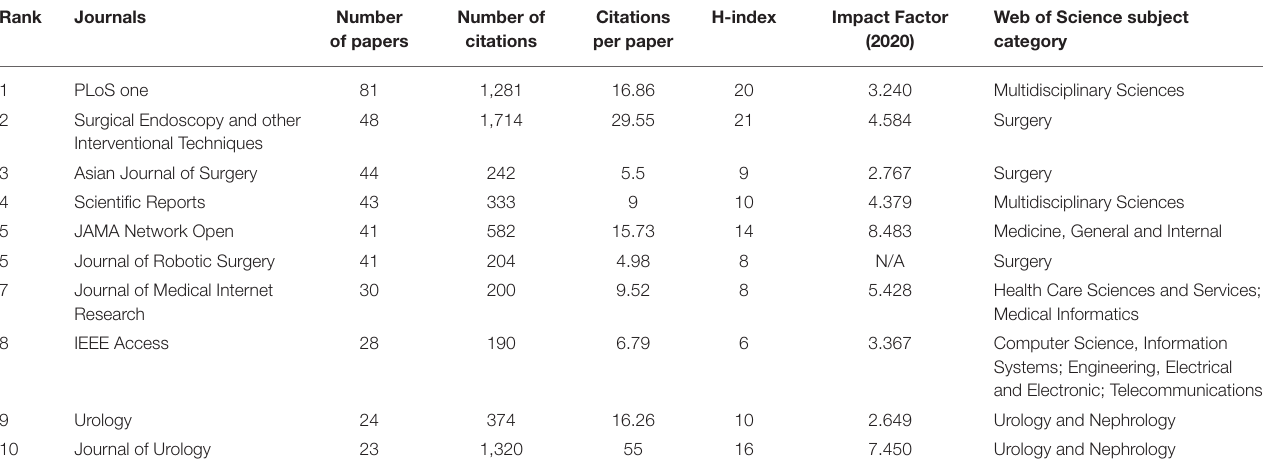
TABLE 5 | The journals with the most gender-related articles in medical artificial